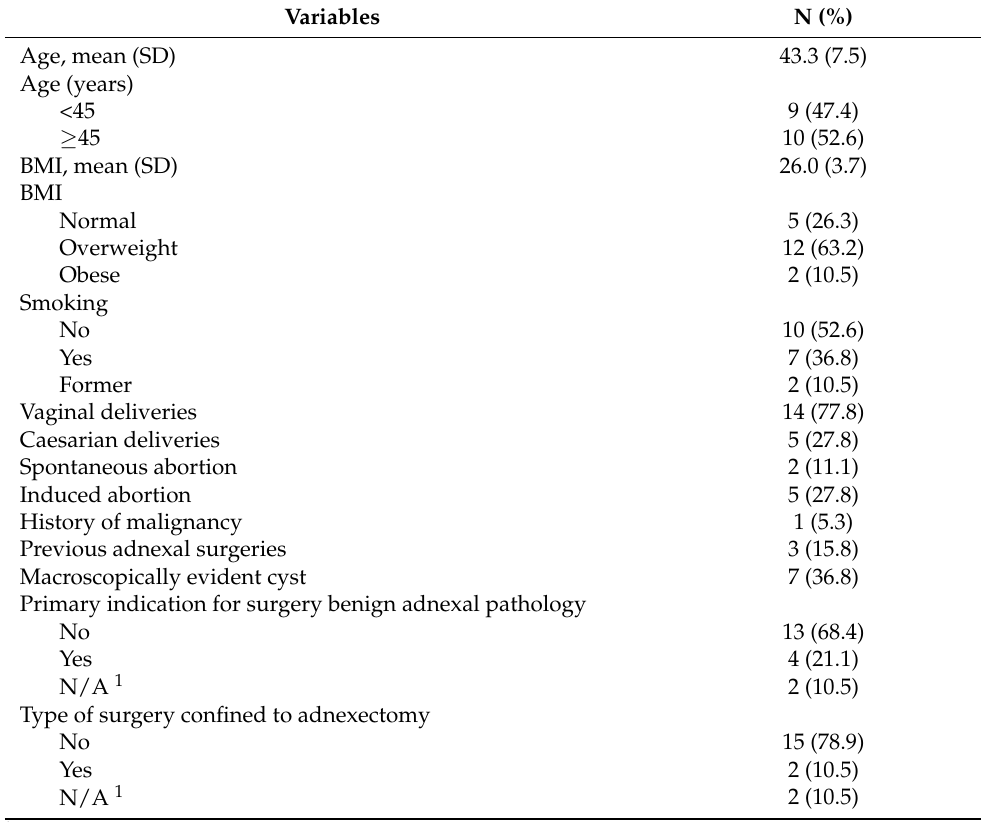
Table 1. Sample characteristics.